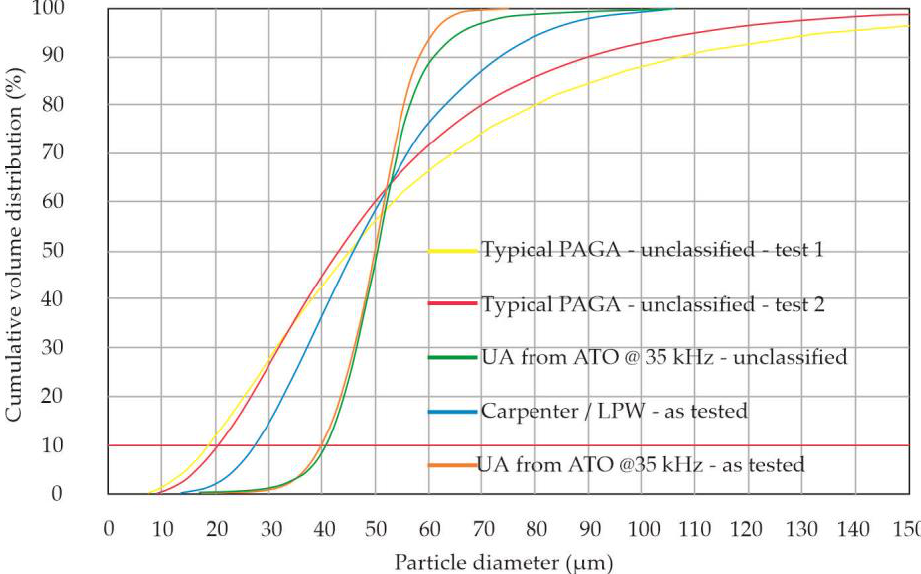
Figure 3. Cumulative statistical distribution (volume %) for the powder batches as in the test campaign, test 1 and test 2 courses were taken from the references [1,3] respectively.